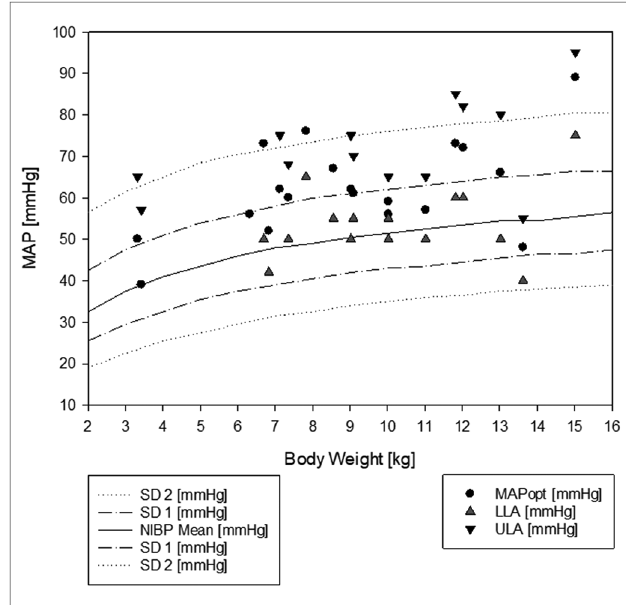
FIGURE 6 Weight-adjusted blood pressure recommendations from the literature with the identi fi ed autoregulated blood pressure range. In the background, weight-adjusted mean blood pressure recommendations from de Graaff (26) are drawn as lines of the mean and fi rst and second standard deviation of the mean blood pressure. In the foreground, the autoregulation parameters are plotted according to the actual patient weight. MAPopt, optimal mean arterial blood pressure; LLA, lower limit of autoregulation; ULA, upper limit of